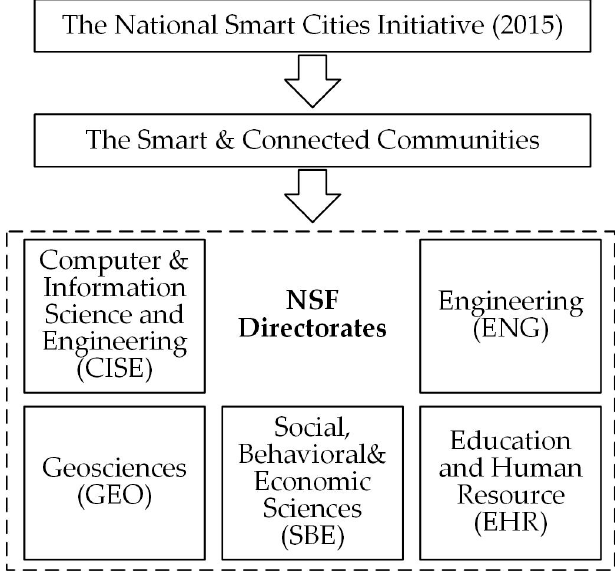
Figure 2. Grants Related to Smart and Connected Communities.